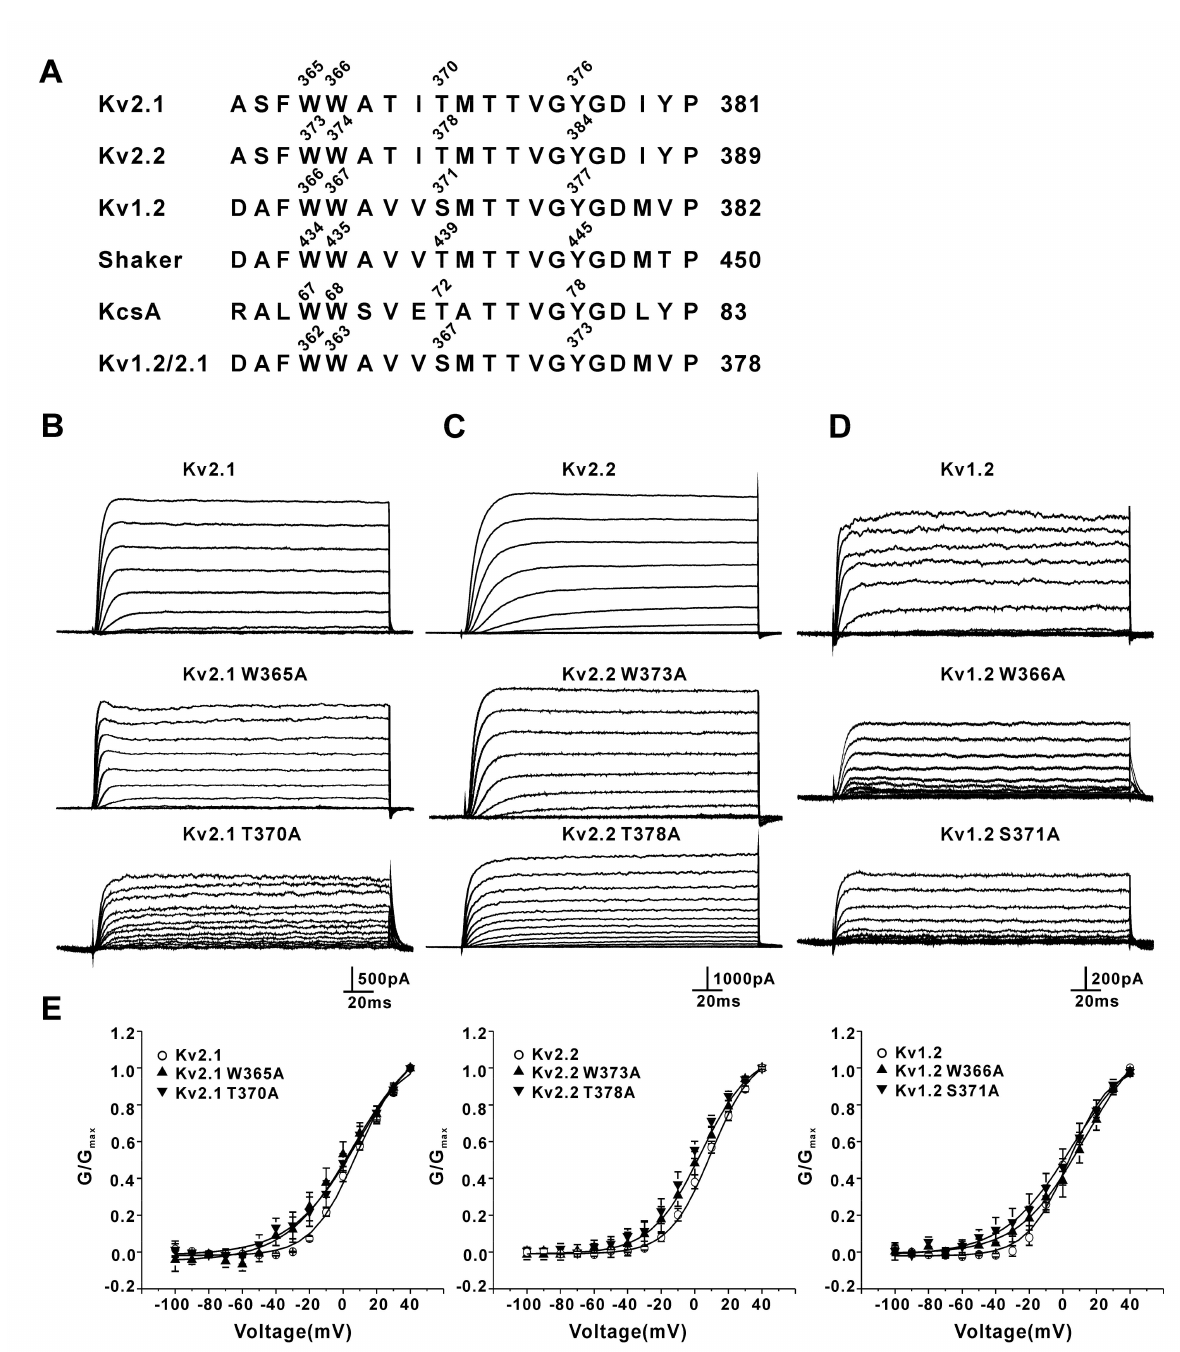
Figure 1. Effects of the mutation of the equivalent residues controlling the slow inactivation of Shaker channels on the rat Kv2.1, Kv2.2, and Kv1.2 channels. ( A ) Sequence alignment of the selectivity filter and pore helix of various K+ channels: Kv2.1 (GI: 6981120), Kv2.2 (GI: 164663795), Kv1.2 (GI: 25742772), Shaker (GI: 288442), KcsA (GI: 61226909), and the Kv1.2/Kv2.1 chimeric channel (PDB: 2R9R). ( B ) Representative currents for the Kv2.1 wild-type, W365A, and T370A mutant channels ( − 100 to +40 mV, 200 ms, in 10-mV increments; n = 8~14). ( C ) Representative currents for the Kv2.2 wild-type, W373A, and T378A mutant channels ( n = 7~12). ( D ) Representative currents for the Kv1.2 wild-type, W366A, and S371A mutant channels ( n = 6–9). ( E ) G-V curves of the wild-type and mutant Kv